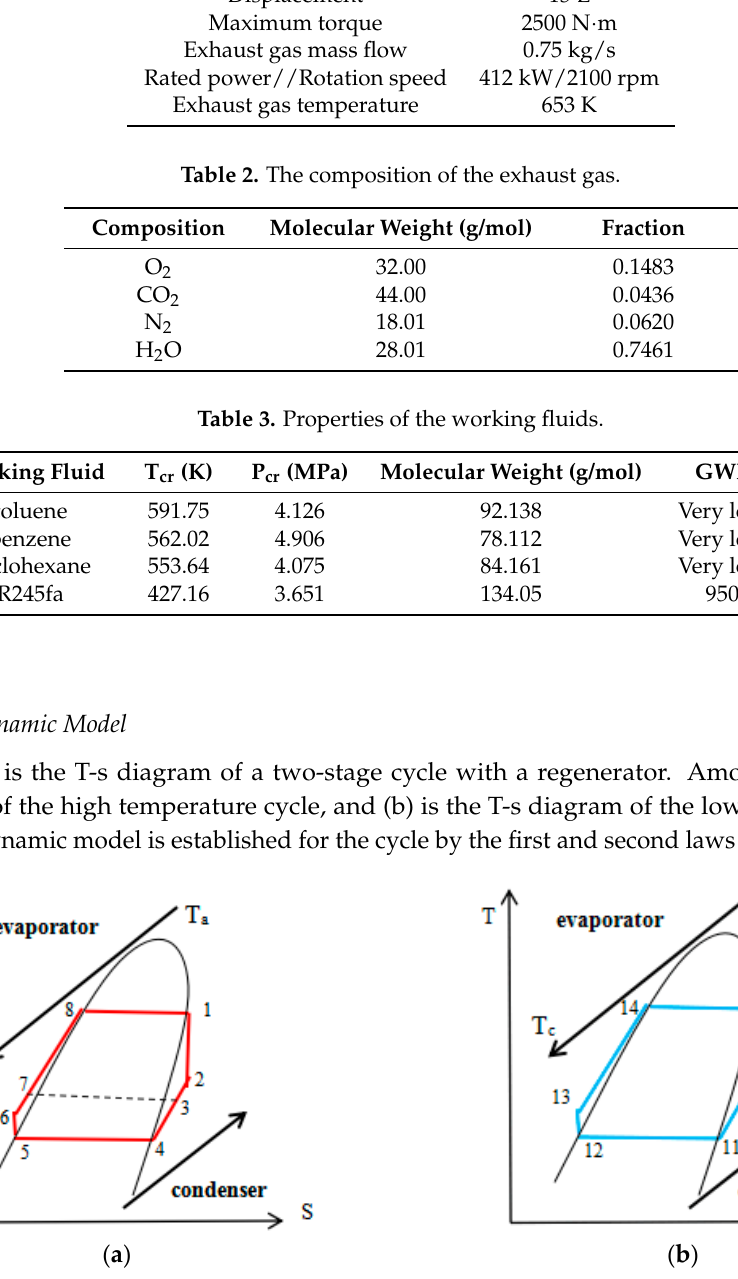
Figure 2. T-s diagram of the dual loop ORC system with regenerator. ( a ) High temperature cycle T-s diagram; ( b ) Low temperature cycle T-s diagram.